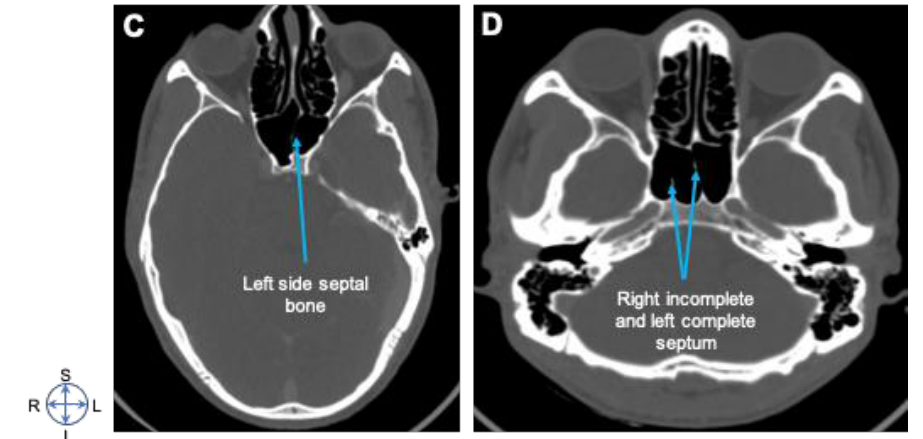
Figure 4. Septation of the sphenoid sinus. Axial CT images showing ( A ) Double inter-sphenoidal septum, ( B ) Right side septal bone, ( C ) Left side septal bone, and ( D ) Right incomplete and left complete septum. Note that almost 90% of the patient population who participated in this study showed single septation, whereas 1% without septation. Image orientation: S, superior; I, inferior; R, right side; L, left side. Diagnostics 2020 , 10 , x FOR PEER REVIEW Table 2. Incidence of sphenoid sinus pneumatization and septation in the Ethiopian population. Anatomographic Variants of the Sphenoid Sinus